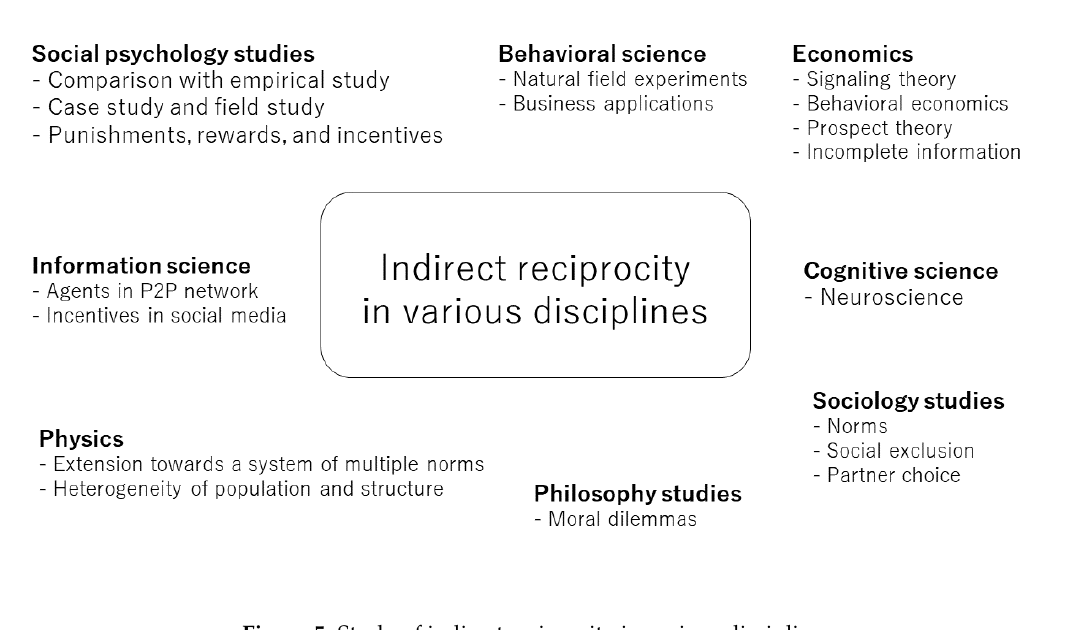
Figure 5. Study of indirect reciprocity in various